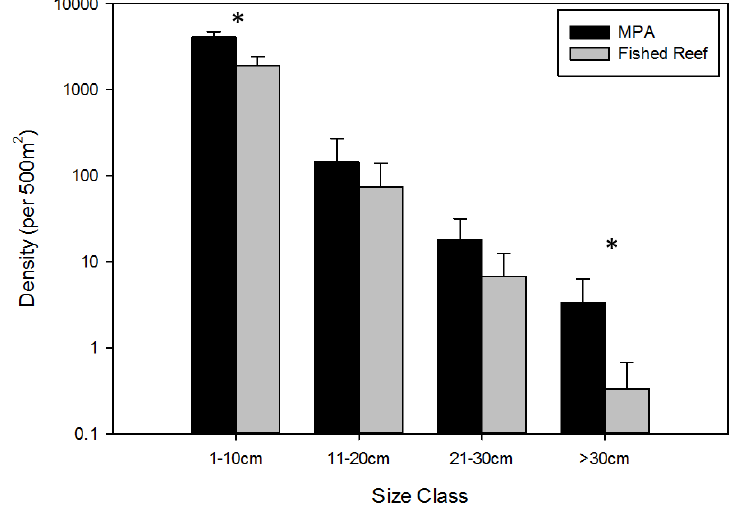
Figure 2. Median ± median absolute deviation (MAD) of the maximum reported densities of all fishes from all censused MPAs. Black bars indicate fish density within MPA borders, and grey bars represent fish density of fished reefs. Asterisks (*) above groups of black and grey bars indicate a significant difference ( p < 0.001) from individual Mann-Whitney U